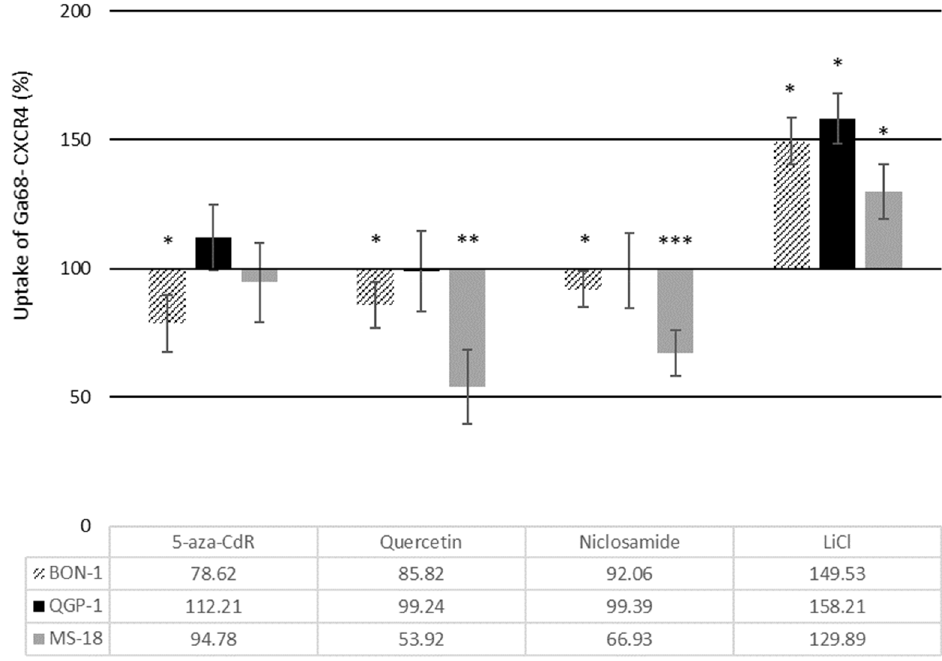
Figure 5. Specific uptake of radiolabeled [Ga68] Pentixafor in BON-1, QGP-1, and MS-18 cells after incubation with Wnt modulators. The data are presented as percentages of untreated controls (mean ± SD; n = 3 experimental repeats; * p < 0.05, ** p < 0.01, and *** p < 0.001).